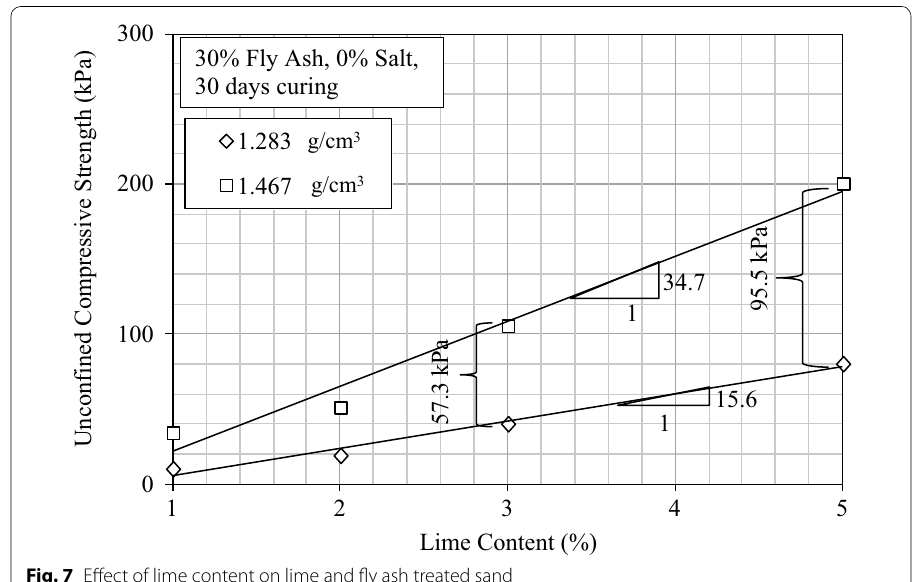
Fig. 7 Effect of lime content on lime and fly ash treated